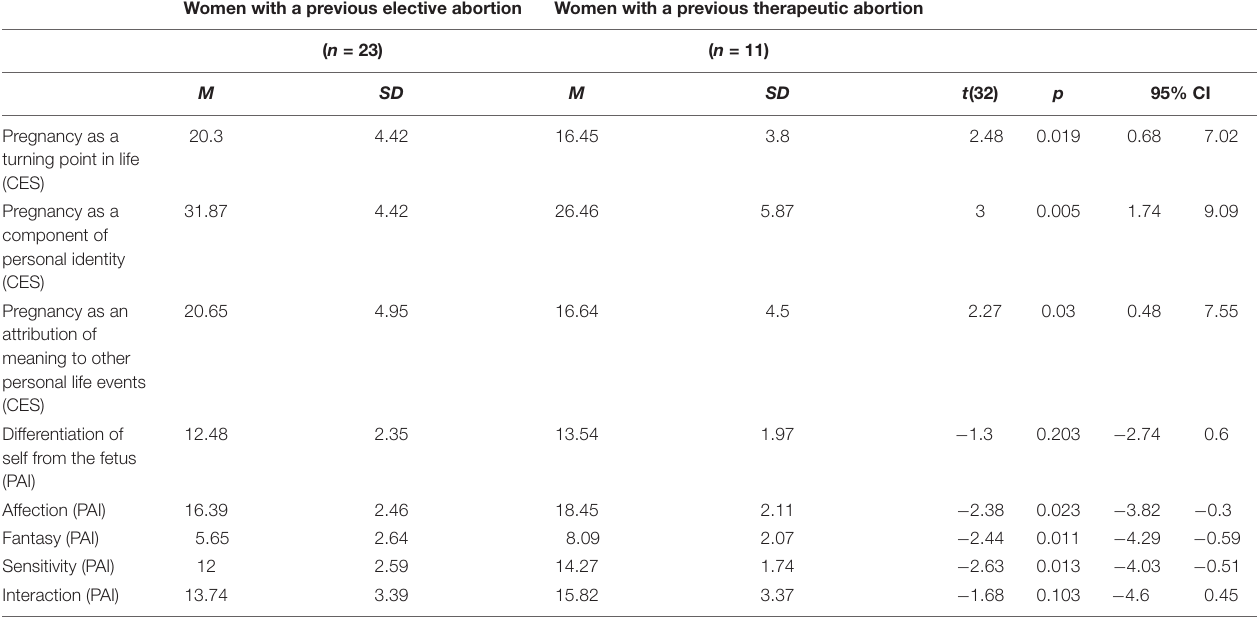
TABLE 2 | Means and standard deviations of the dimensions of the CES and the PAI in women with a history of previous elective and therapeutic abortion and independent t -tests results. Women with a previous elective abortion Women with a previous therapeutic